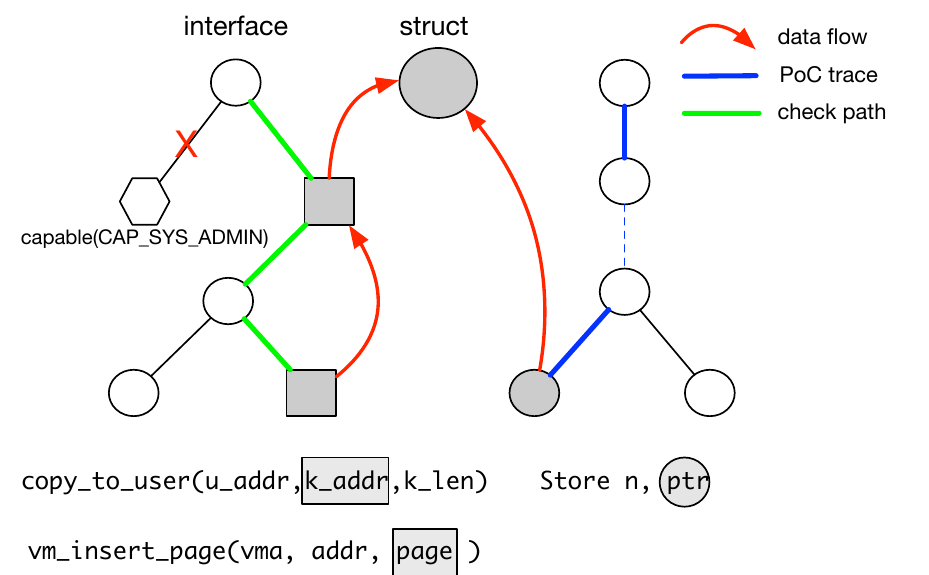
Figure 7. Illustration of backward taint analysis starting from copy_to_user() , vm_insert_page() , and ptr . Arguments k_addr and ptr originate from the same structure. Interface refers to a system call or an export function from a